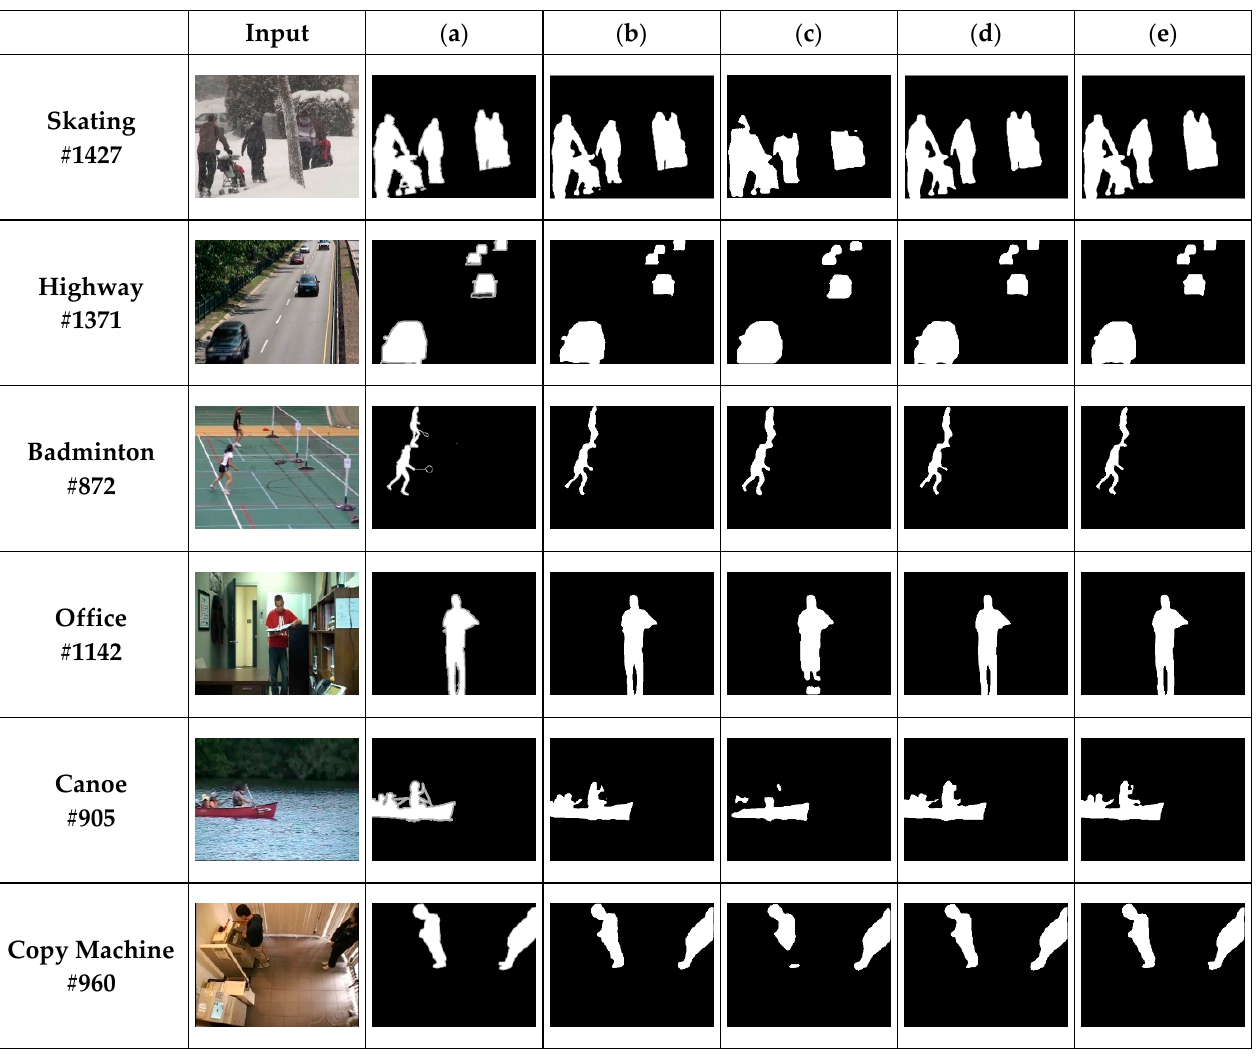
Figure 4. Test results on scenes used for the training in the CDnet 2014 dataset: ( a ) ground truth foreground maps, ( b ) proposed method, ( c ) SuBSENSE [2], ( d ) modified FgSegNet-v2, ( e ) FgSegNet-v2 [42].